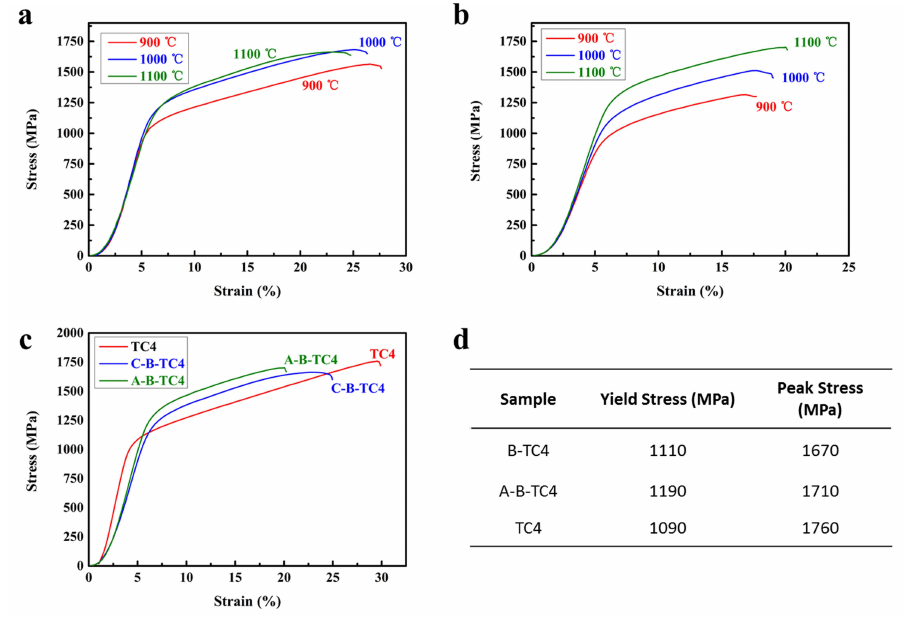
Figure 9. The compression strength curves of different groups of samples, ( a ) with C-B addition; ( b ) with A-B addition; ( c ) comparison between TMCs and the matrix material; ( d ) specific node